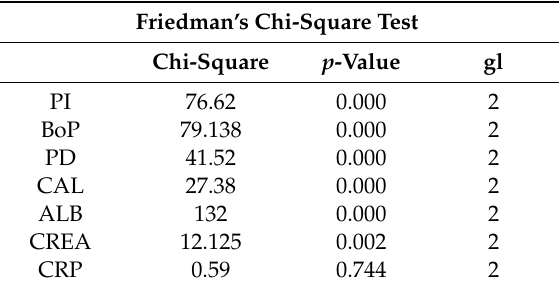
Table 2. Friedman’s test for di ff erences of variables at three time